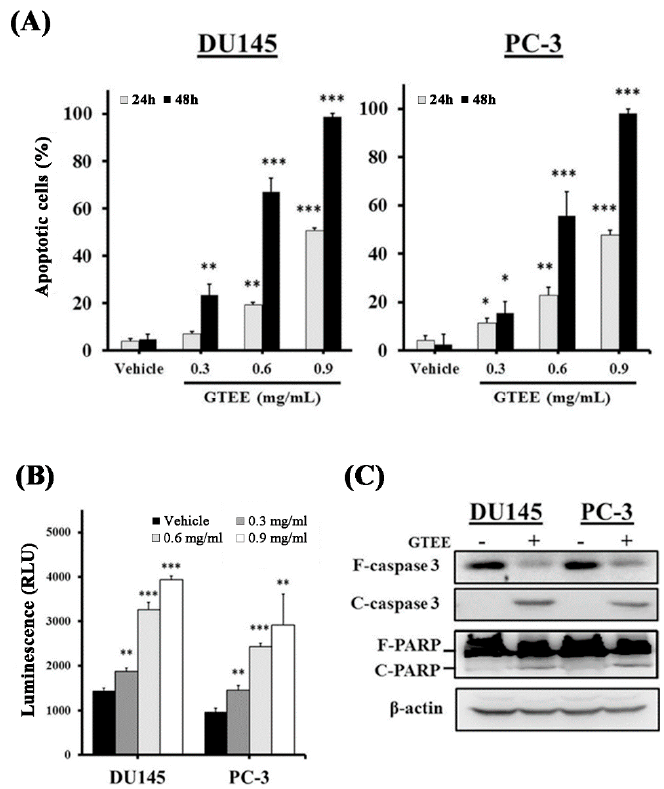
Figure 4. GTEE induces caspase-dependent apoptosis in mPCa cells. ( A ) After 24 or 48 h treatment of vehicle or GTEE (0.3, 0.6 and 0.9 mg/mL), apoptotic cells (%) of DU145 and PC-3 were determined by flow cytometry-based Annexin V-FITC and PI staining analysis. Data are shown as the mean ± SD of three independent experiments. * P < 0.05, ** P < 0.01, *** P < 0.001. ( B ) GTEE induced caspase-3/7 activity in both DU145 and PC-3 cells in a concentration-dependent pattern. Luminescence detection (RLU) of caspase-3/7 activity was measured by an enzymatic activity assay. Results represent the mean ± SD of triplicate experiments. ** P < 0.01, *** P < 0.001. ( C ) Western blot analysis of apoptosis-related markers (caspase-3 and PARP) in DU145 and PC-3 cells treated with vehicle or GTEE (0.9 mg/mL) for 18 h. GTEE decreased full length (F)-caspase-3 and -PARP, and increased cleaved (C)-caspase-3 and -PARP expression in both mPCa cells. β -actin was used as a loading control.